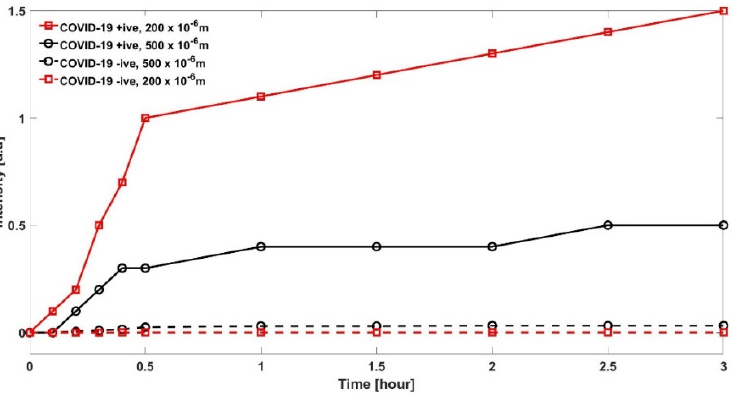
Figure 6. Comparison of two POFs in terms of intensity with diameters 200 and 500 µm are compared with specimen with a COVID-19 positive and negative result.